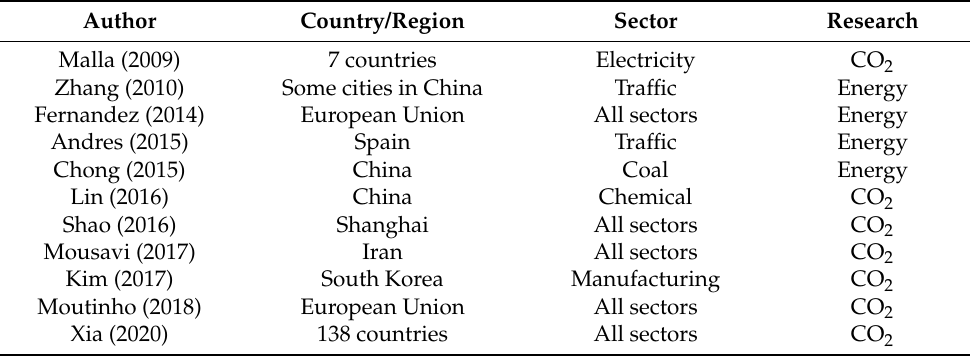
Table 1. LMDI method in the field of energy and